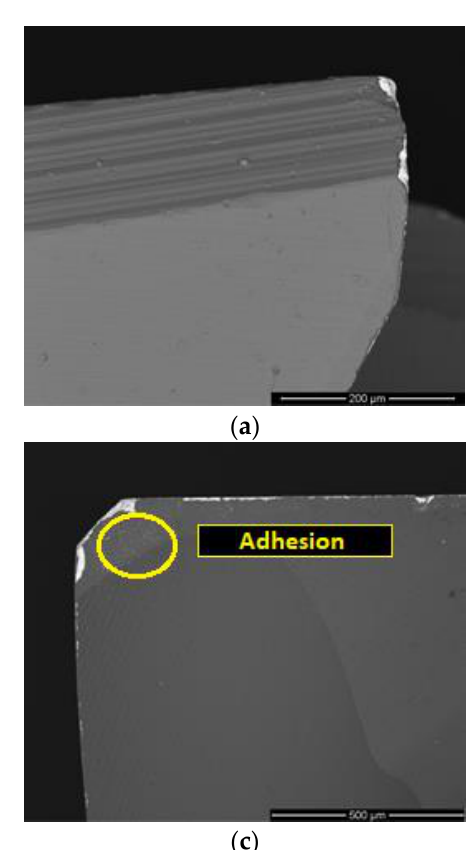
Figure 7. Clearance face, with a 500× magnification, of the T1L2F75 ( a ) and T1L2F125 ( b ) tools, and rake face, with a 500× magnification, of the T1L2F75 ( c ) and T1L2F125 ( d ) tools.